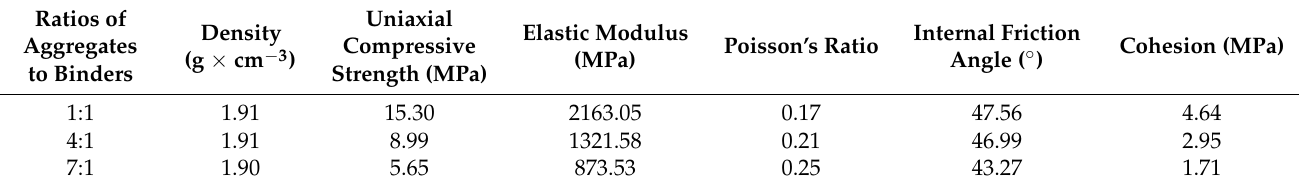
Table 4. Physical and mechanical parameters.